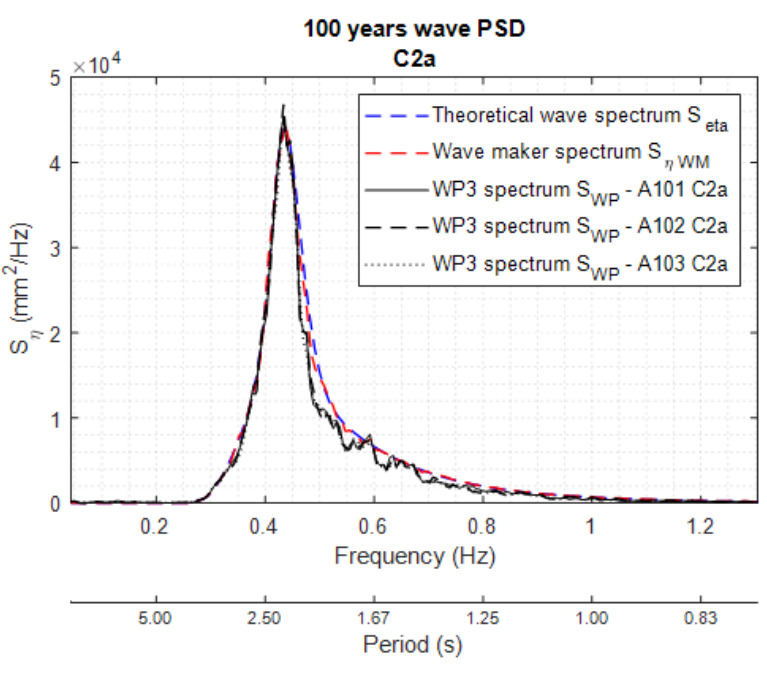
Figure 20. Waves power spectral density: 100-year wave.